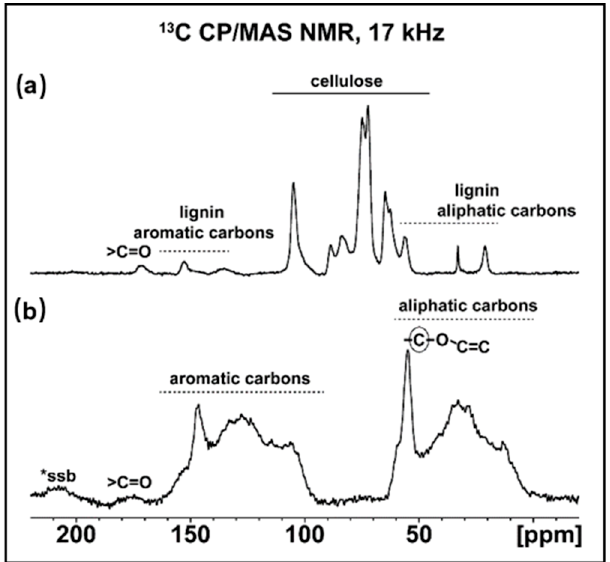
Figure 2. Experimental 13 C CP/MAS NMR spectra of ( a ) raw sawdust and ( b ) pyrolyzed